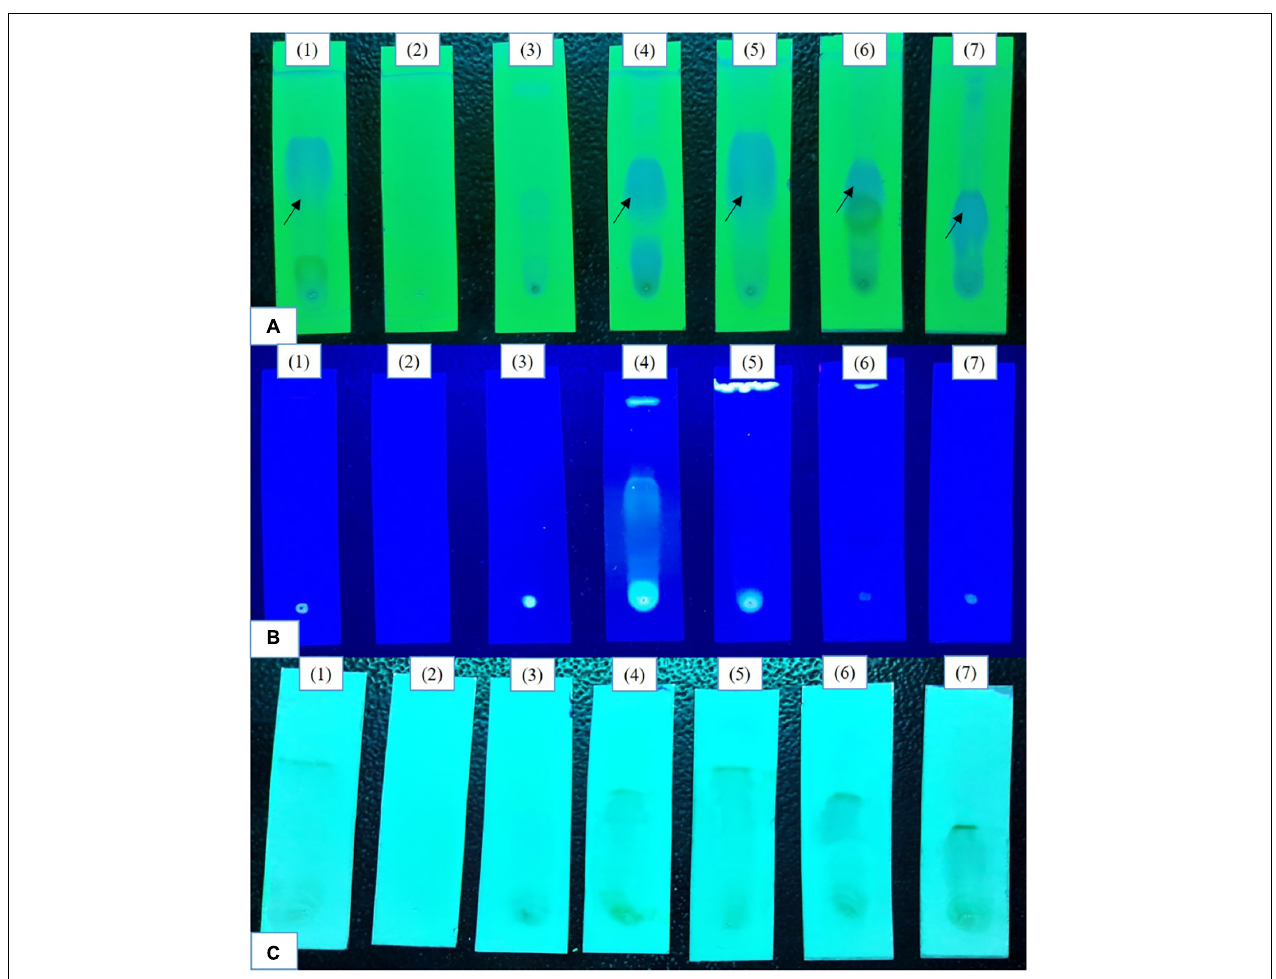
FIGURE 1 | Comparative analysis of the TLC profiles produced by the strain with and without the epigenetic modifier treatment (500 µ M) (A) 254 nm (short UV); (B) 365 nm (long UV); (C) TLC sprayed with chromophore agent vanillin. Control (1), 5-azacytidine (2), Valproic acid (3), Hydralazine Hydrochloride (4), Sodium butyrate (5), Quercetin (6), and SAHA